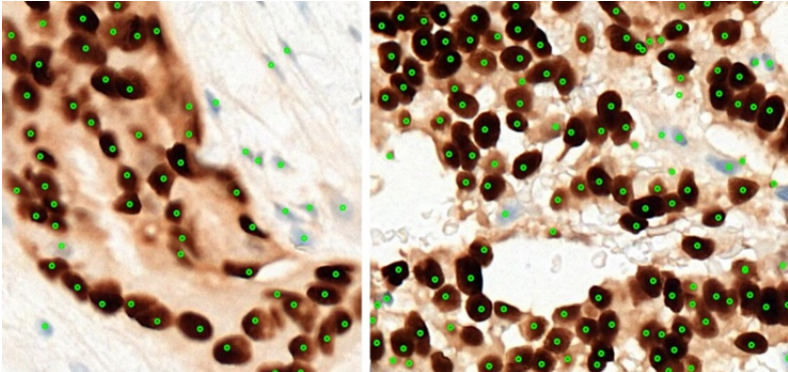
Figure 6. Two of the thirty-seven regions used for the cell detection and classification experiments.